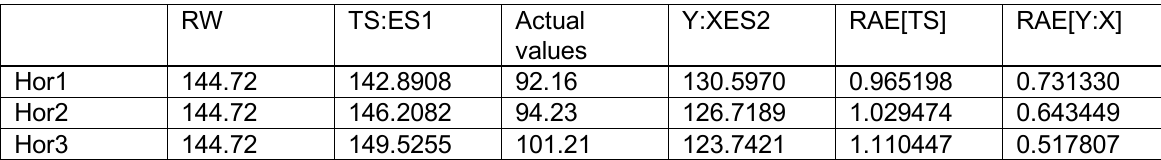
Table 7: The RAE profile for an Y:X Model v. the OLS Model RW TS:ES1 Actual Y:XES2 RAE[TS] values